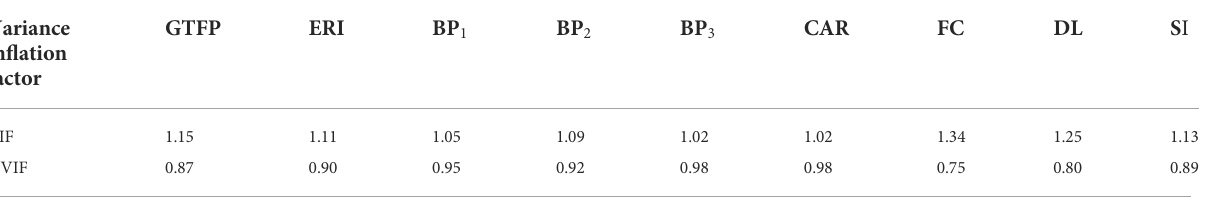
TABLE 3 Variance in fl ation factors.